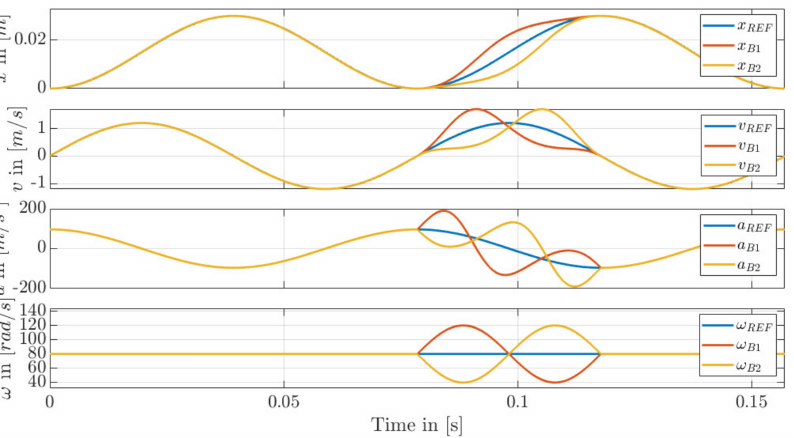
Figure 11. Comparison between the reference curve and compression and extension in the operating point ω = 80 rad , x peak = 0.03 m, ∆ ω T 1 = 0 rad s ω = 80 rad , x peak = 0.03 m, ∆ ω T 1 = 0 rad s